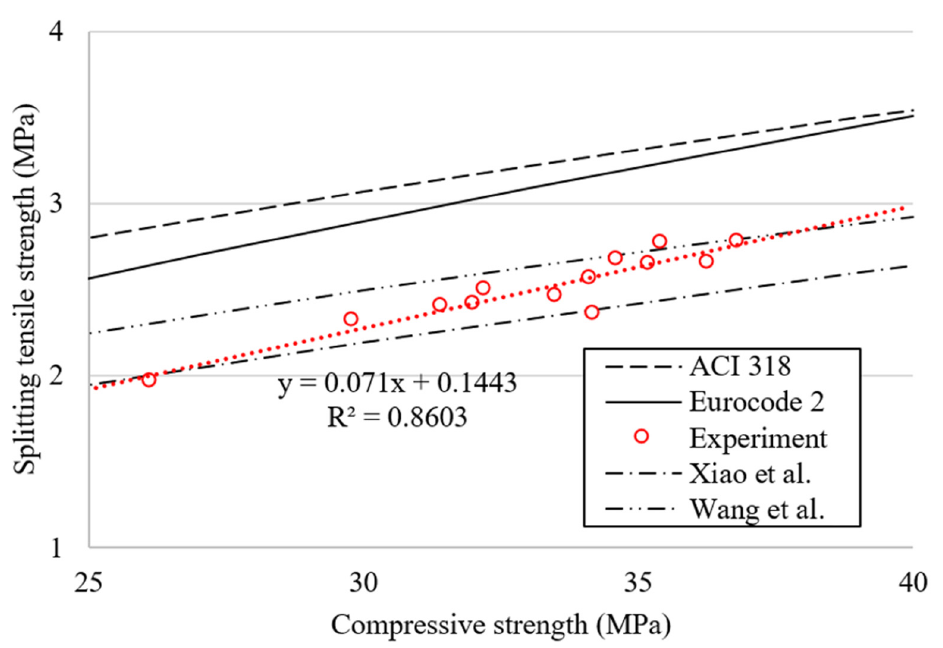
13 of 19 Figure 10. Correlation between compressive strength and density.